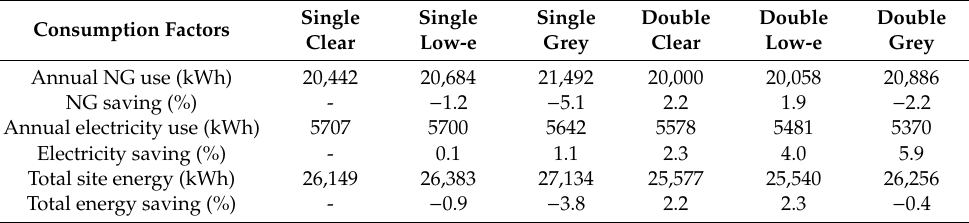
Figure 12. Monthly electricity consumption for different glazing types. Table 10. The annual energy consumption and energy saving for various glazing